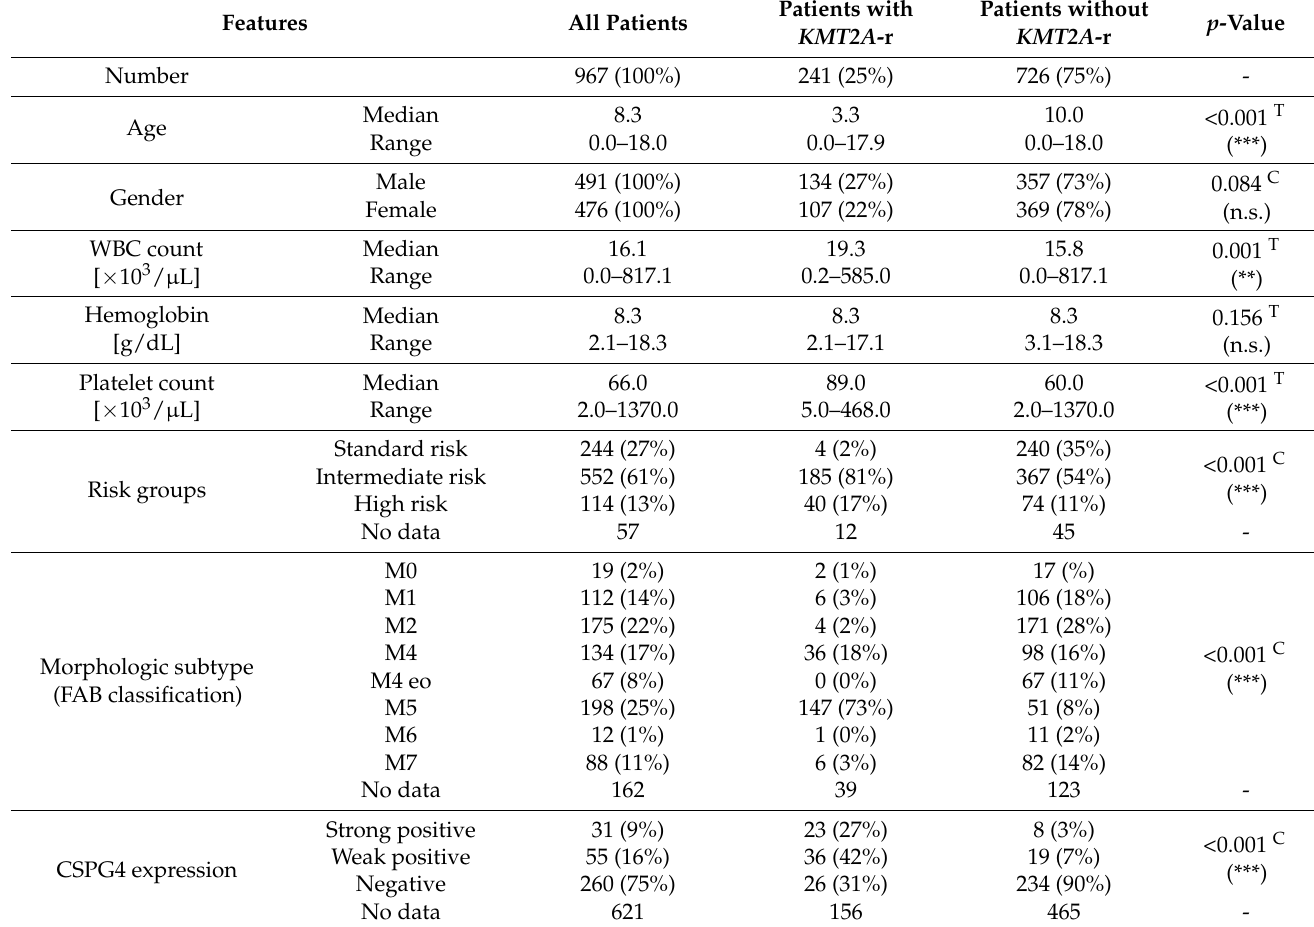
Table 1. Clinical characteristics of pediatric AML patients with and without KMT2A -r at